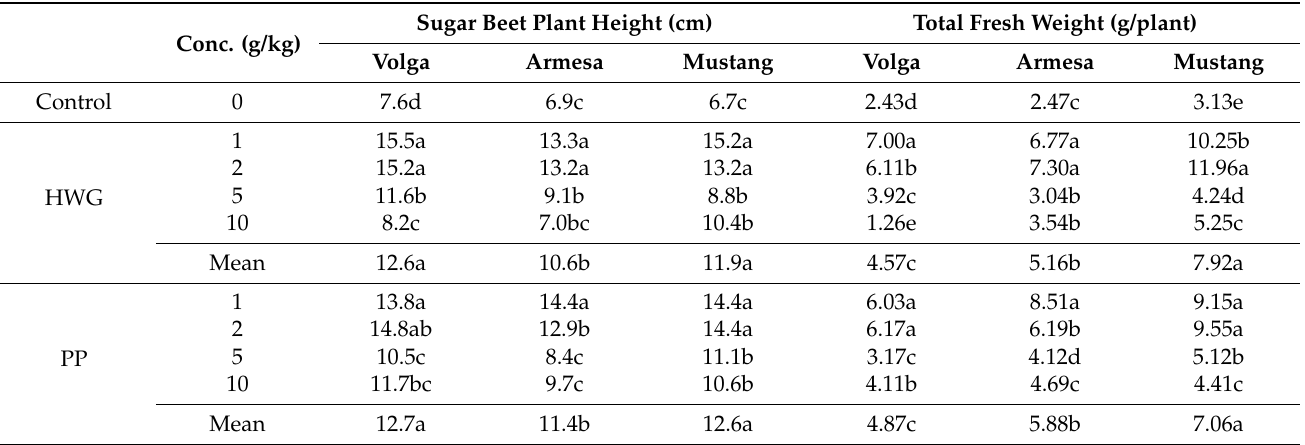
Table 2. Plant height and total fresh weight of sugar beet cultivars (Volga, Armesa, Mustang) treated with hydrolyzed wheat gluten (HWG) and potato protein (PP). Source: Jolayemi et al. [61]. Conc.